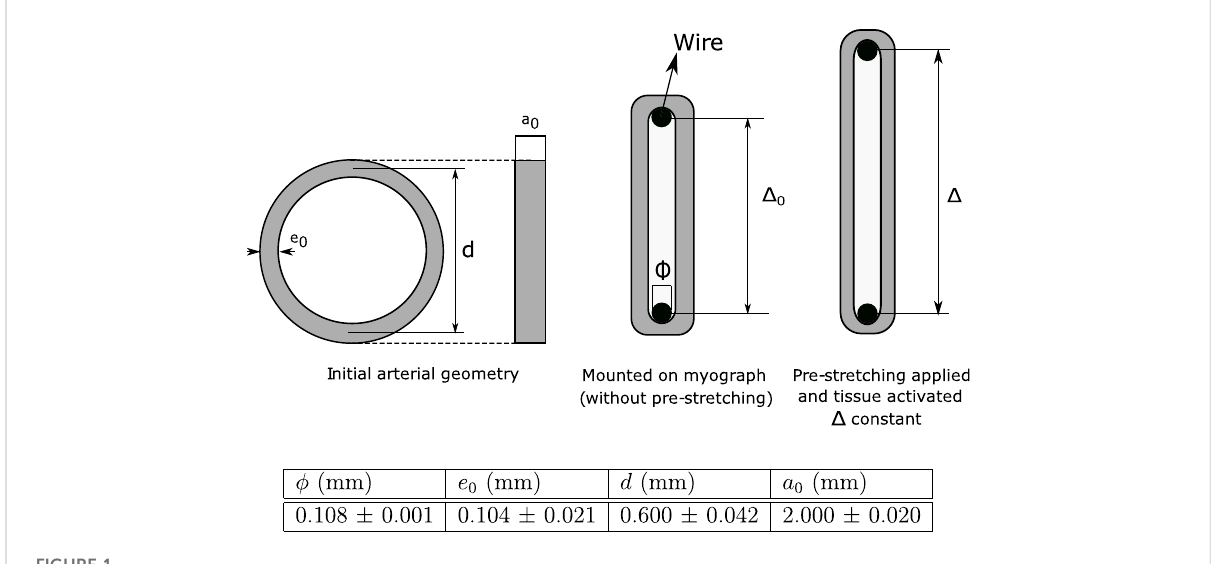
FIGURE 1 Scheme of the isometric contraction test and experimental values (± standard